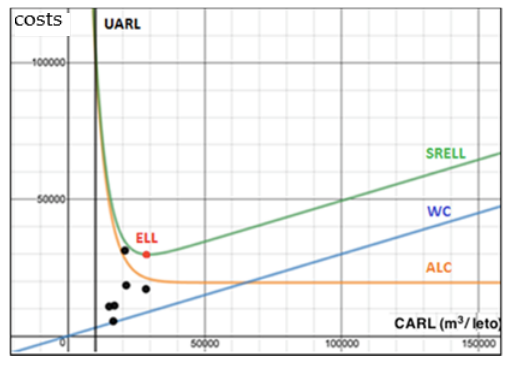
Figure 3. Parameters of short term economic losses in VO ‐ KA company (Lipoglav). Source: Calculation based on company’s data.